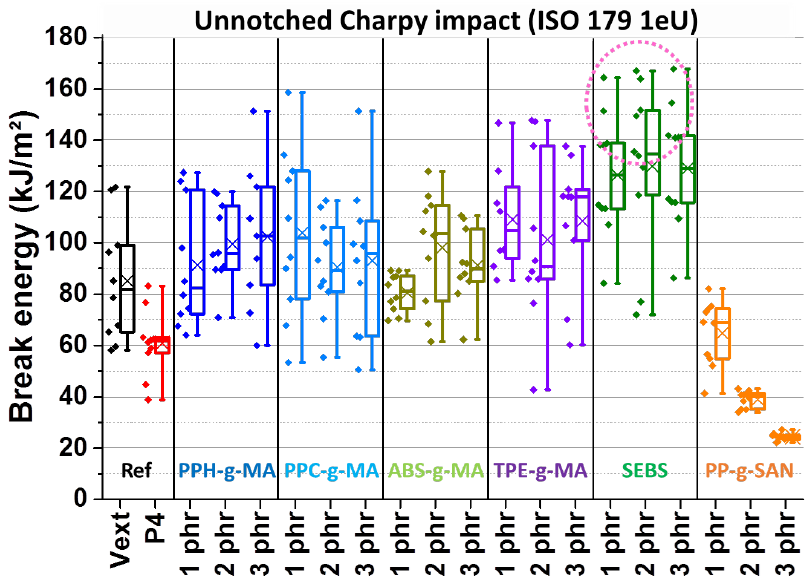
Figure 10. Unnotched Charpy impact break energies—same batches and denominations as previous figure—circle for partial breaks, respectively, 4, 5 and 4 specimens for 1, 2 and 3 phr of SEBS.